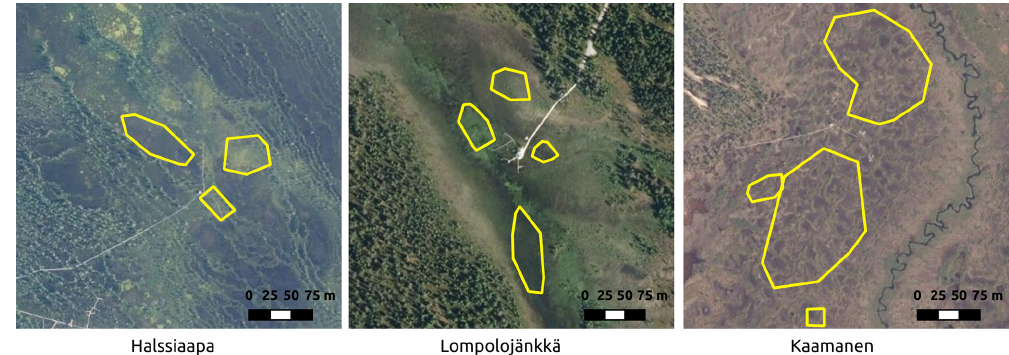
Figure 2. The regions of interest (ROIs) representing the overall vegetation at the sites for the Sentinel-2 satellite images. The aerial photo contains data from the National Land Survey of Finland Topographic Database.